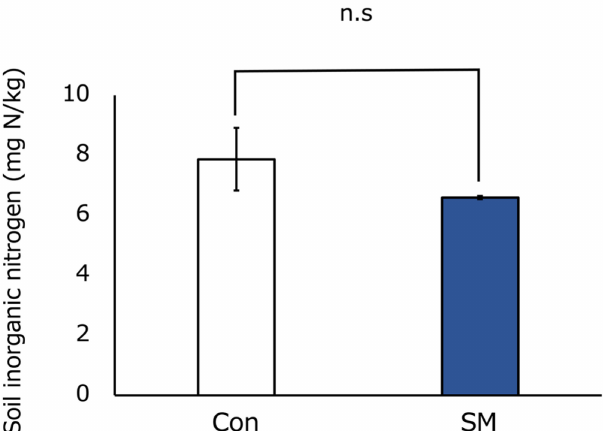
Figure 2. The daily average soil temperature ( a ) and moisture ( b ) from April to May 2017. Black line = control (Con) plots and gray line = snowmelt (SM) plots. The data are the average value of two sensors.